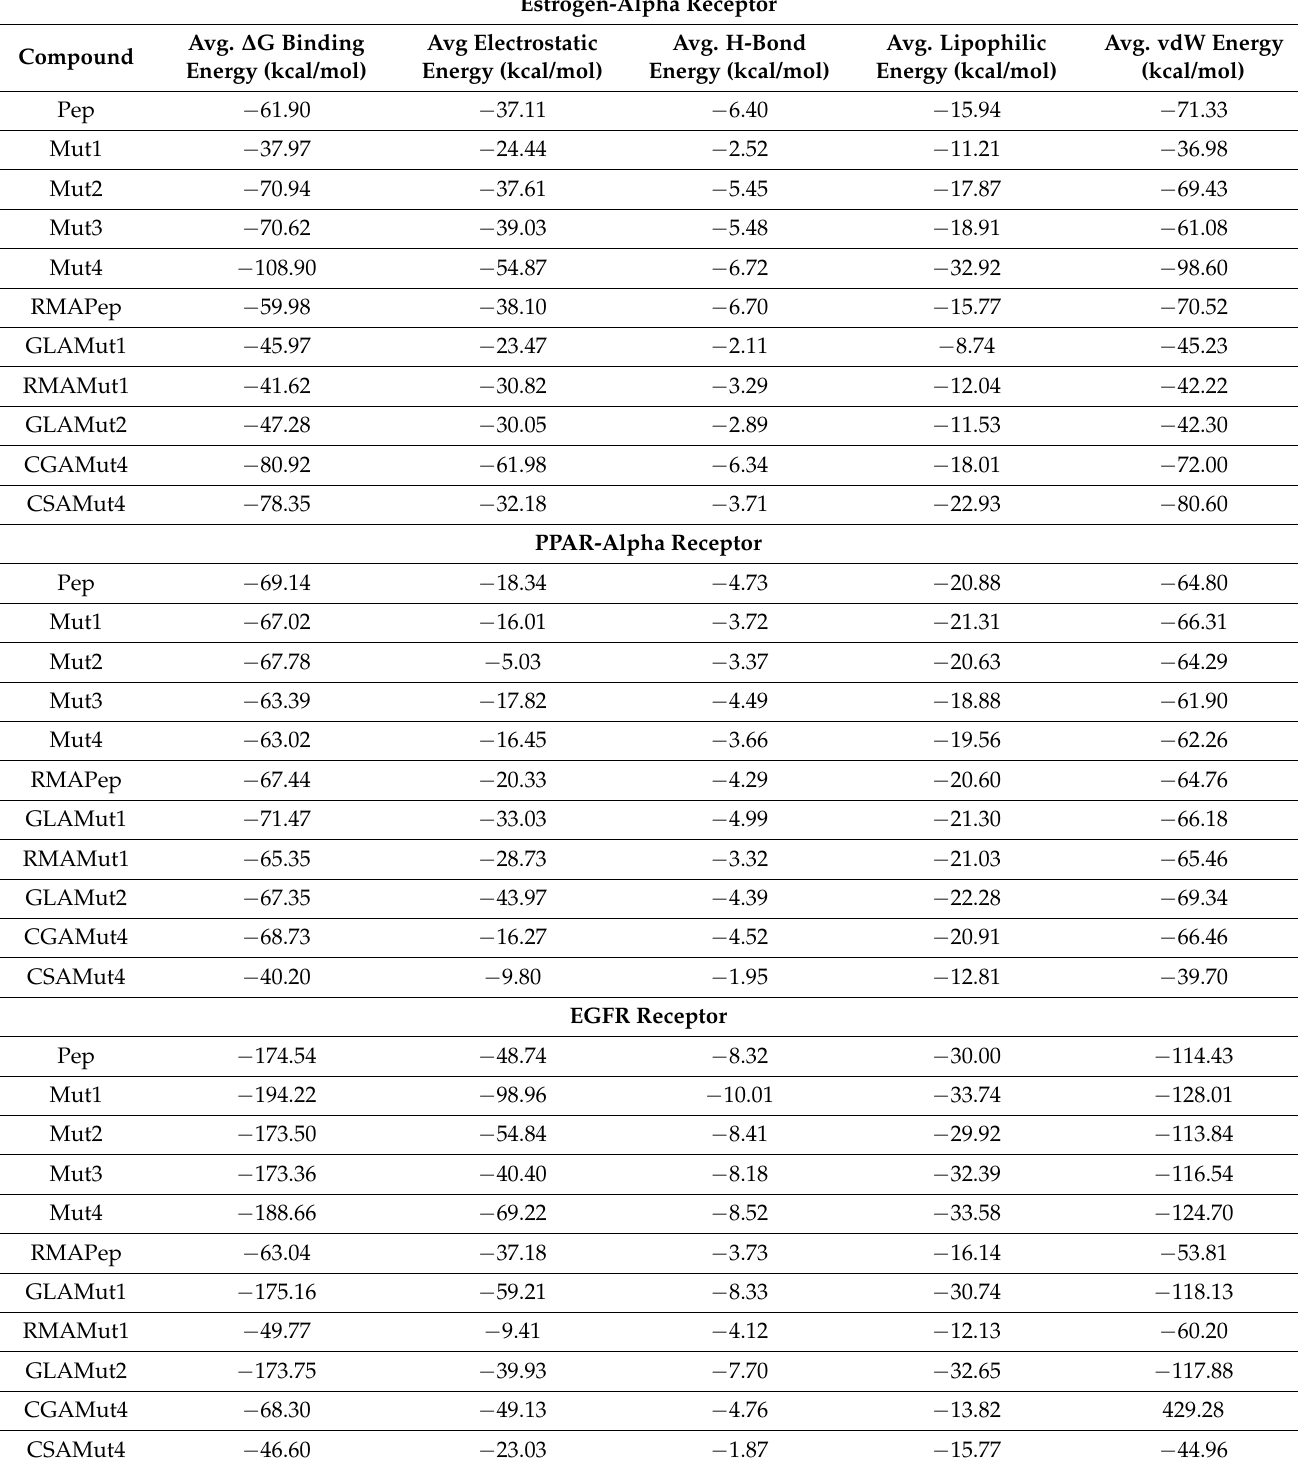
Table 5. Comparison of MMGBSA